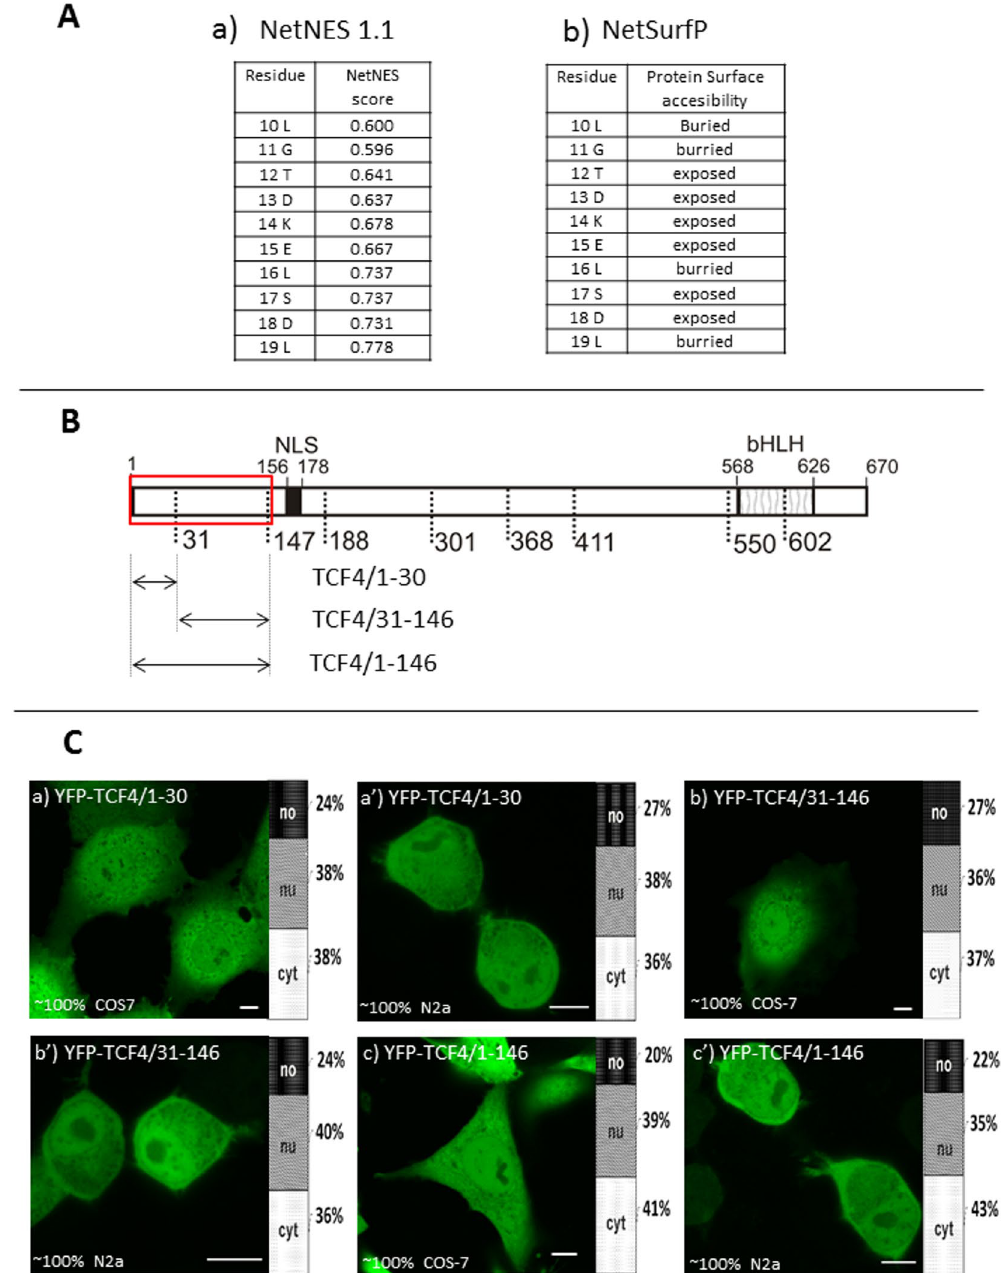
Figure 2. Subcellular distribution of deletion mutants (1-146aa) of TCF4 ( A ) Results of NetNES1.1(a) and NetSurfP (b) Predictors ( B ) Schematic representation of TCF4 protein. Regions of the TCF4 (NLS and SMART predicted bHLH) are depicted using different patterns and upper numbering of aa residues. The length of each domain in the diagram is arbitrary. Bottom aa residues refer to first aa residues of all TCF4 fragments used in this study. Region of actual studied area of TCF4 is shown by the red rectangle. Expressed deletion mutants of TCF4 are depicted as arrows and particular deletion mutants are depicted as arrows. The same fashion is used for Figs 2–4 and 6–10 ( C ) Subcellular distribution of deletion mutants of TCF4. Subcellular localizations of the expressed proteins were analysed by confocal microscopy 20-24 h after transfecting COS-7 and N2a cells. Representative images (single confocal plane for confocal microscopy) of subcellular distribution of the derivatives of the TCF4/1-146 area. Bar, 10 µ m. Ratios between mean fluorescence intensity in cytoplasmic, nuclear and nucleolar compartments are presented as an accumulated bar graph (no- nucleolus; nu- nucleus, cyt- cytoplasm). (a,a’) YFP-TCF4/1-30, (b,b’) YFP-TCF4/31-146, (c,c’) YFP-TCF4/1-146, ( C ) Results of NetNES1.1(a) and NetSurfP (b)